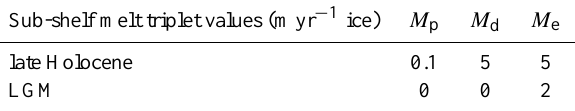
Table 1. Sub-shelf melt triplet values used in the ice shelf melting parameterization that is employed here. M p =protected shelf melt values, M d =deepwater shelf melt values, M e =exposed shelf melt values. For more information, see Pollard and DeConto